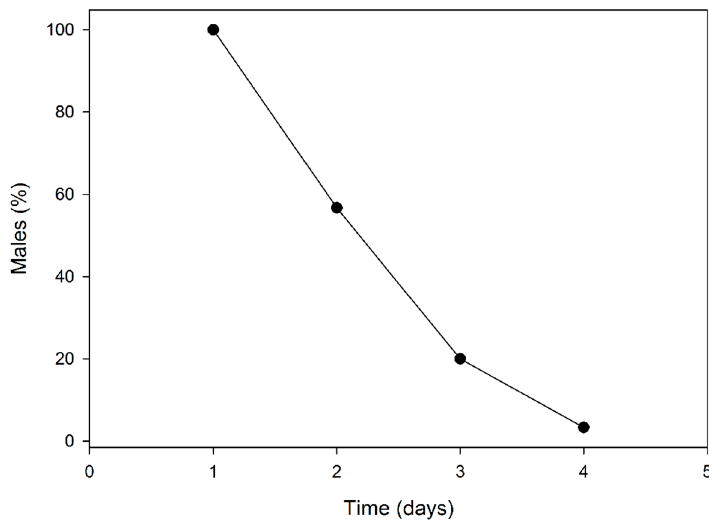
Figure 2. Longevity of P. calceolariae males subjected to multiple mating under laboratory conditions.